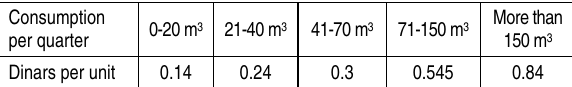
Table 1. Tariff of water distribution in